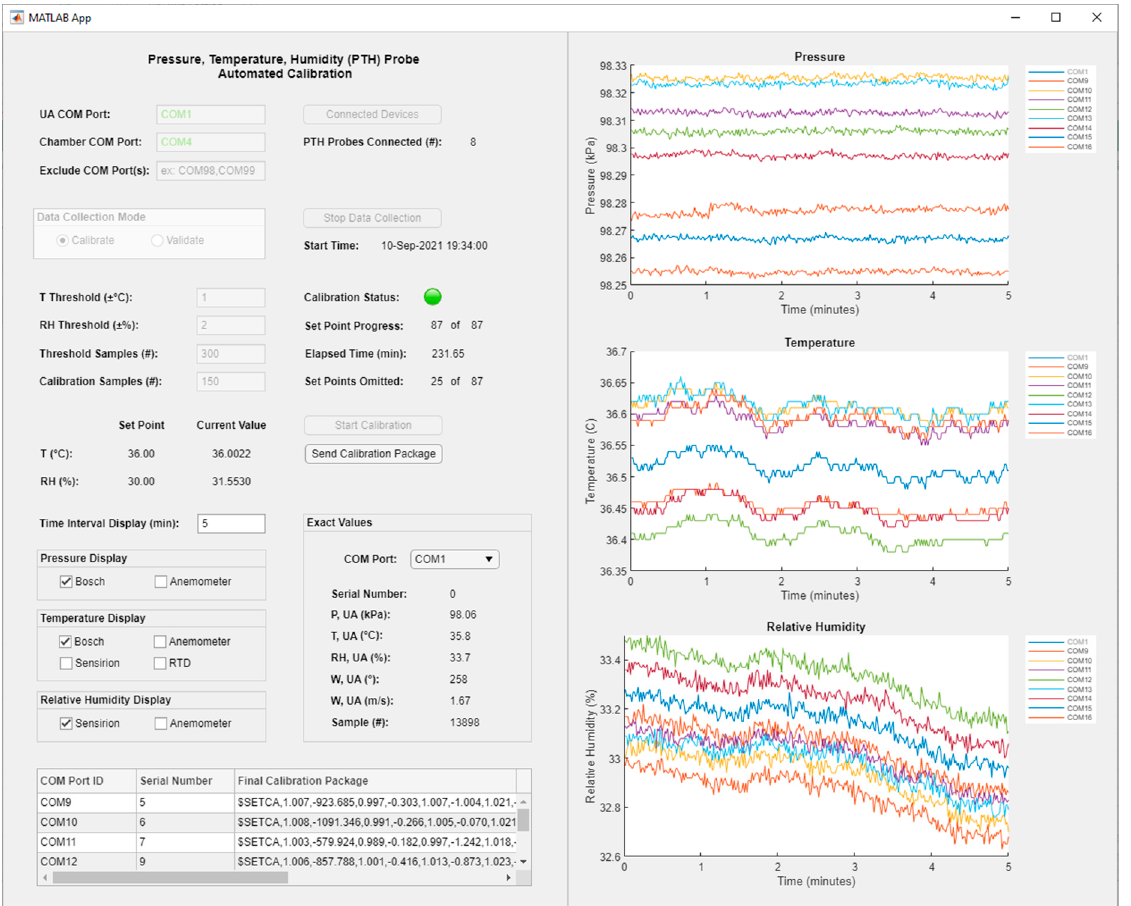
Figure 8. Automated calibration program graphical user interface developed in MATLAB App Designer environment.